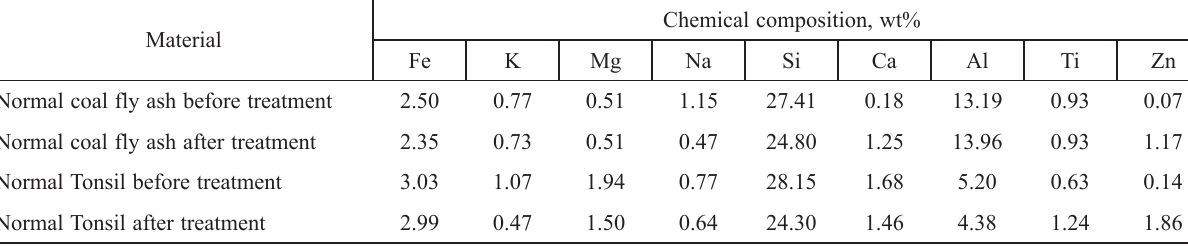
Table 1 – Chemical composition of the solid sorbent before and after Zn sorption Chemical composition, wt% Material Fe Normal coal fly ash before treatment Normal coal fly ash after treatment Normal Tonsil before treatment Normal Tonsil after